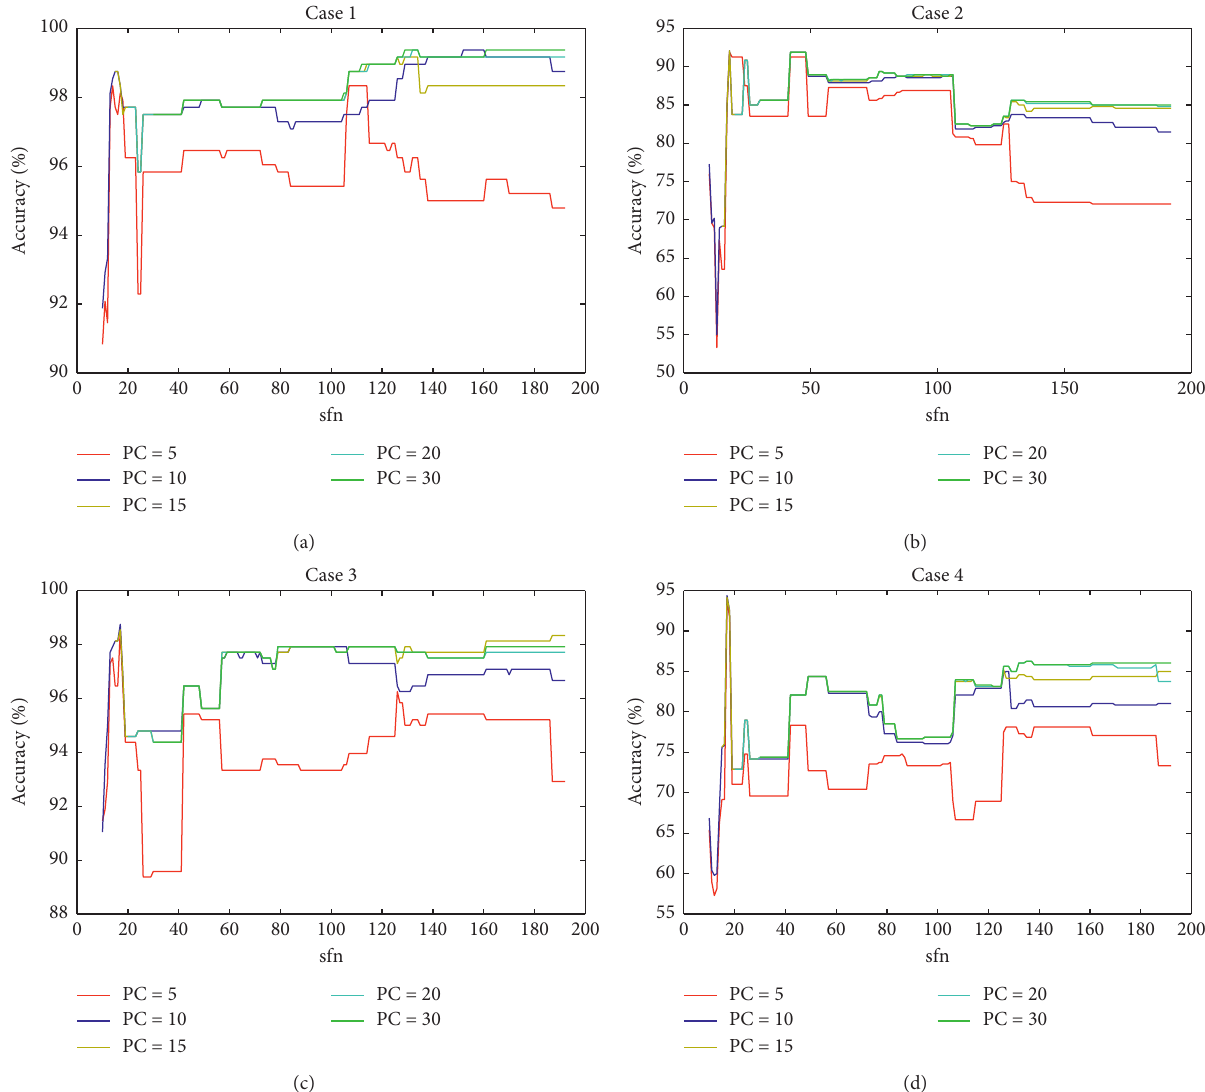
Figure 8: The curve representation of diagnosis results obtained by OFS-TSFRS-PCA-SVM using DTCWPTwith different dimension sizes for PCA. The PC represents the number of dimension